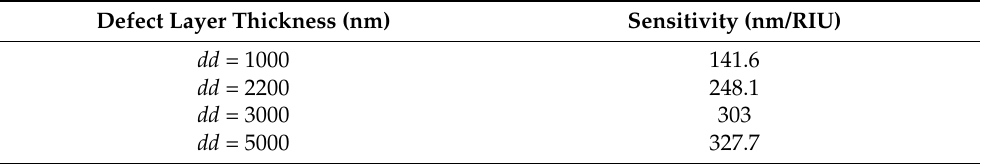
Figure 6. Transmission spectra showing five defect modes in solid blue, black, brown, yellow and purple line colors corresponding to RBC sample containing A, B, C, D and E blood cells separately, one at a time. The thickness of cavity layer is dd = 2200 nm under normal incidence. Table 2. Sensitivity calculations of proposed biosensors corresponding to different defect layer